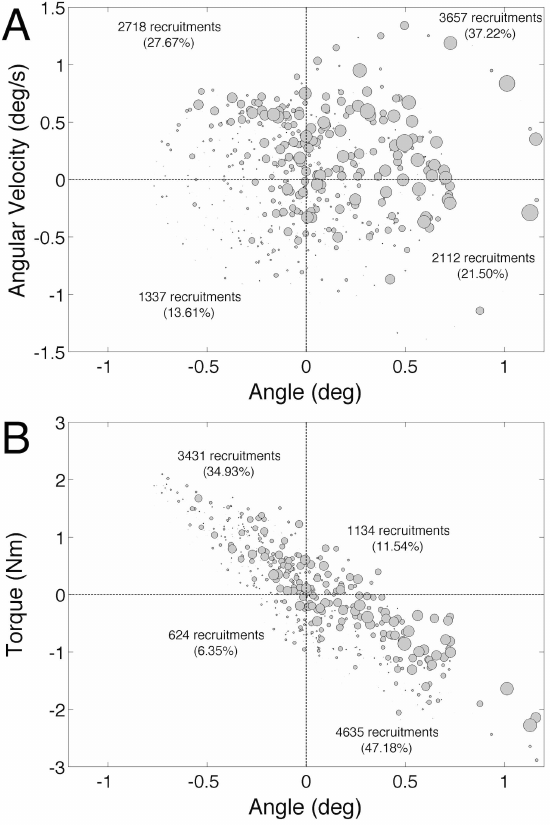
Figure 6. Recruitment phase plots. (A) Phase plot showing the recruitment of Medial Gastrocnemius (MG) motor units (MUs) in angle- velocity bi-dimensional graph. The point (0,0) is a reference due to the subtraction of the mean value of each variable obtained in the simulations. Circle diameters are proportional to the number of recruited MUs (see Methods). It is noteworthy that MUs seem to be preferentially recruited in the first quadrant, i.e., when the pendulum is leaning forward as it comes from a backward position. (B) Phase plot showing the recruitment of MG MUs in angle-torque bi-dimensional graph. Again, the point (0,0) is a reference that was used because each simulation produced slightly different mean torques and angles. Note that MG MUs are mostly activated in the fourth quadrant, i.e., when the pendulum is leaning forward and the plantar-flexion torque produced by Triceps Surae (TS) is higher than the mean.